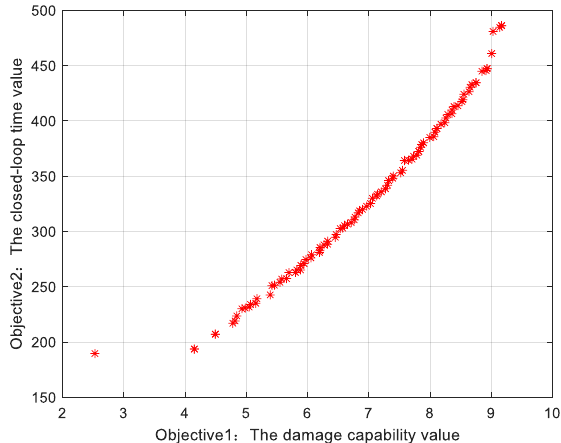
Figure 6. Pareto front.